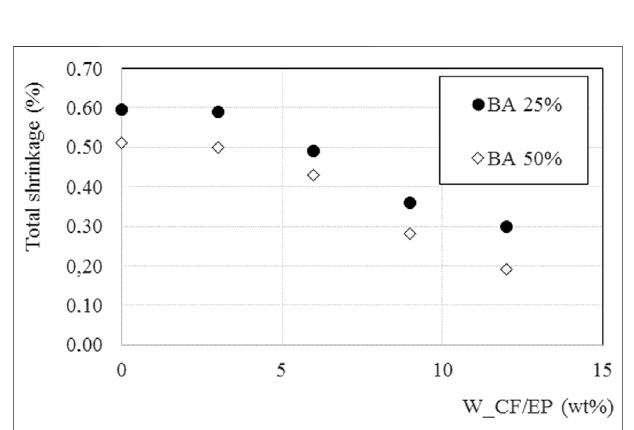
FIGURE11| Dimensionalchangesforsamplescuredat35 ± 5%relative humidity.